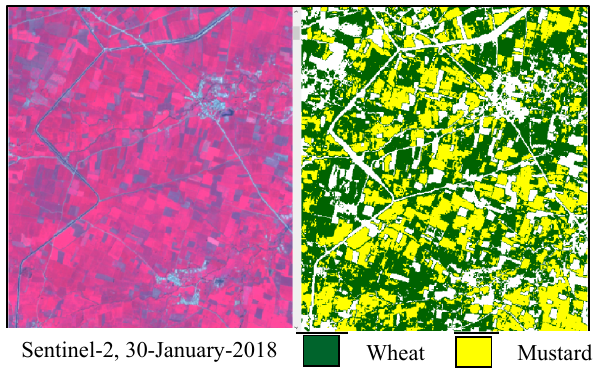
Figure 7. Showing RD (%) of area and production from 2013- 2017